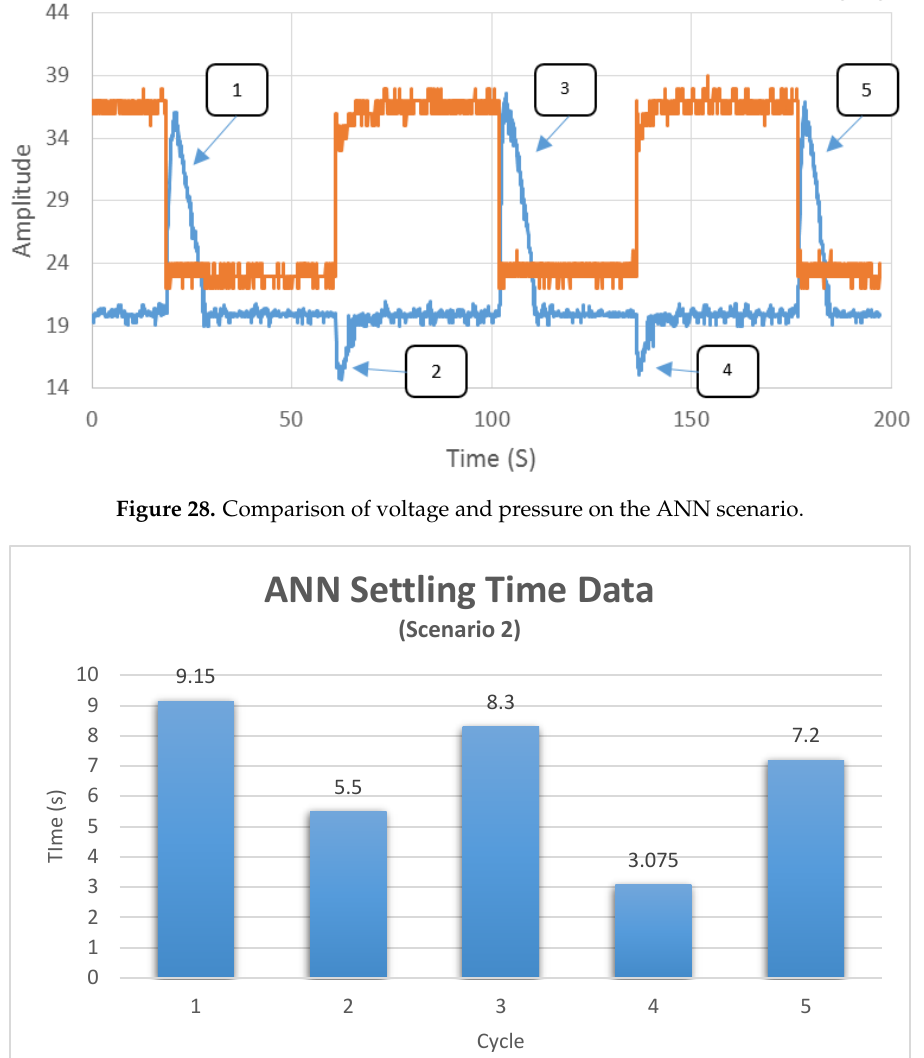
Figure 29. Comparison of settling time on each cycle in ANN scenario.